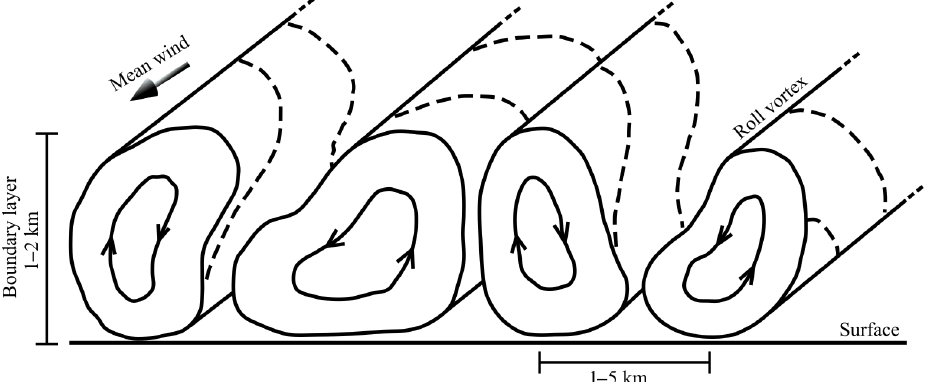
Figure 1. A schematic drawing of roll vortices in the boundary